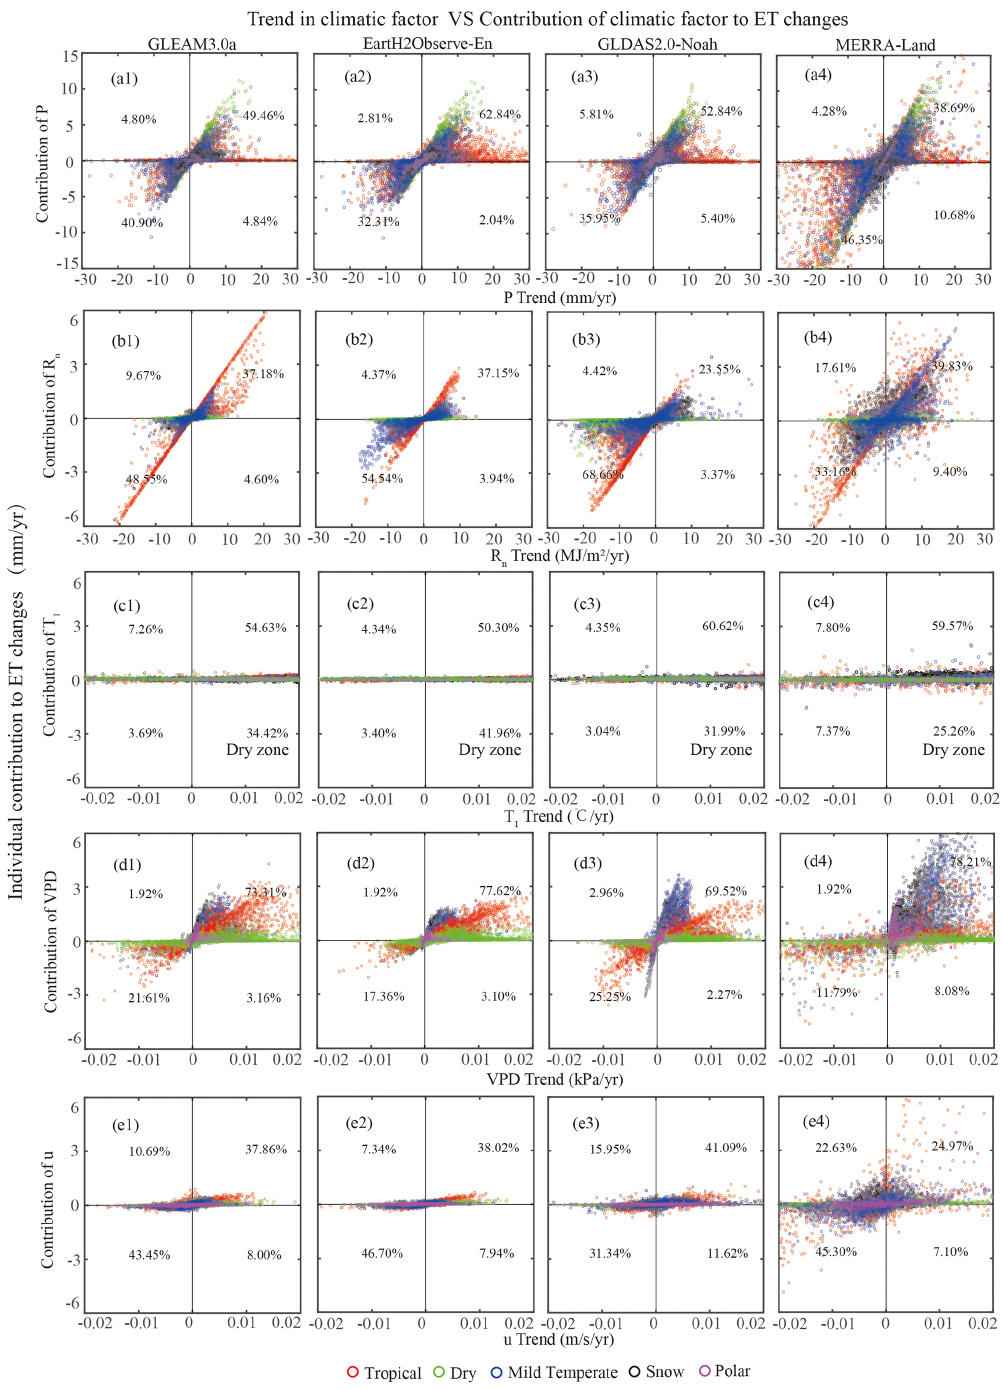
Figure 3. Pixel-wise scatterplots of ( x axis) trends in each climatic variable against ( y axis) the contribution of each climatic variable to ET changes. Small letters (a–e) indicate precipitation, radiation, air temperature ( T 1 ), VPD and wind speed, respectively; and numbers (1– 4) indicate GLEAM3.0a, EartH2Observe-En, GLDAS2.0-Noah, and MERRA-Land, respectively. The percentage is the ratio between the number of grid cells in each quadrant and the number of total grid cells; the sum of the percentage values in the four quadrants equals to 100%. The color red, green, blue, black purple represents Tropical, Dry, Mild Temperate, Snow, Polar zones, respectively.